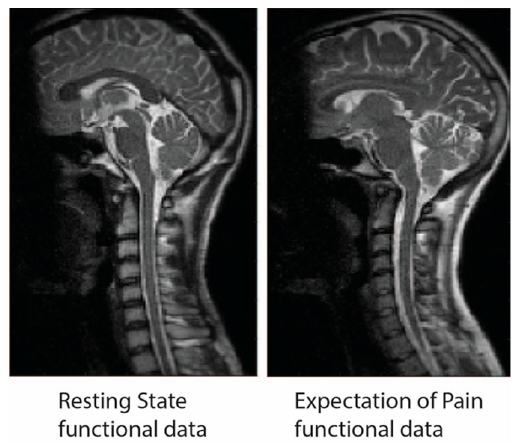
Figure 2. Examples of sagittal-slice functional data from an individual in the ‘resting state’ and an individual in the ‘expectation of pain’ data set for comparison. As both studies collected data with the same methods on the same scanner, the quality of the two data sets is equivalent.